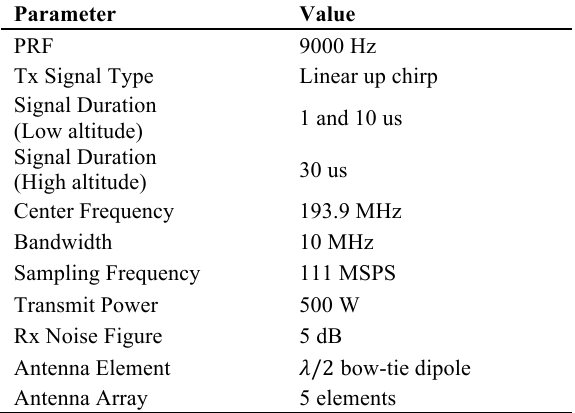
Table 1. Basic MCoRDS radar parameter (Shi et al.